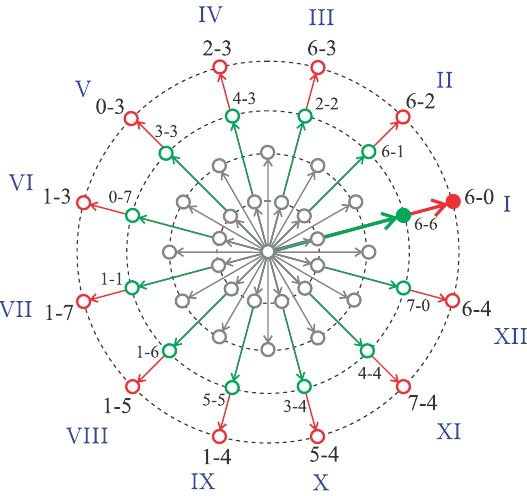
Figure 3. Space sectors in the α – β plane for MPC with